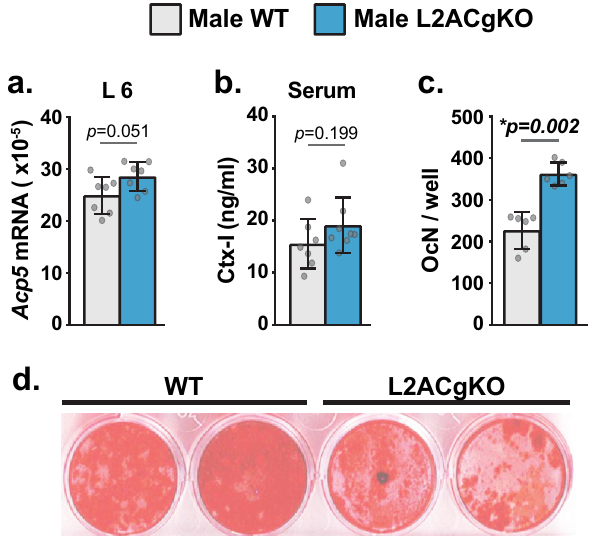
Figure 5. CMA-deficiency is associated with increased osteoclastogenesis. (a,b) Bone resorption markers were measured in 18-week-old male Lamp2AC global knock-out (L2ACgKO) mice and their control littermates (wild type mice, WT). ( a) qRT-PCR analysis was used to measure mRNA levels of osteoclast marker gene TRAP ( Acp5 ) in lumbar vertebrae 6 (L6). TRAP mRNA levels were measured and normalized to the housekeeping gene β-actin. ( b ) Circulating bone resorption marker C-terminal telopeptide of type I collagen (Ctx-I) was measured by ELISA. ( a,b ) n = 7–8 mice/group. Bars indicate mean ± STDEV. p values were calculated and evaluated by student’s t -test; *, p < 0.05. ( c ) Bone marrow was isolated from 4-month-old L2ACgKO and WT mice. Bone marrow of 3 mice/genotype were pooled and plated for in vitro osteoclast formation assays. additional times with bone marrow isolated from different sets of mice. These data and representative images of the osteoclast cultures can be found in S. Fig. 5d, Bone marrow was isolated from 4-month-old L2ACgKO and WT mice. Cells were differentiated into osteoblasts by culturing with osteogenic media for 28 days. Alizarin Red staining was used to determine mineral deposition by differentiated